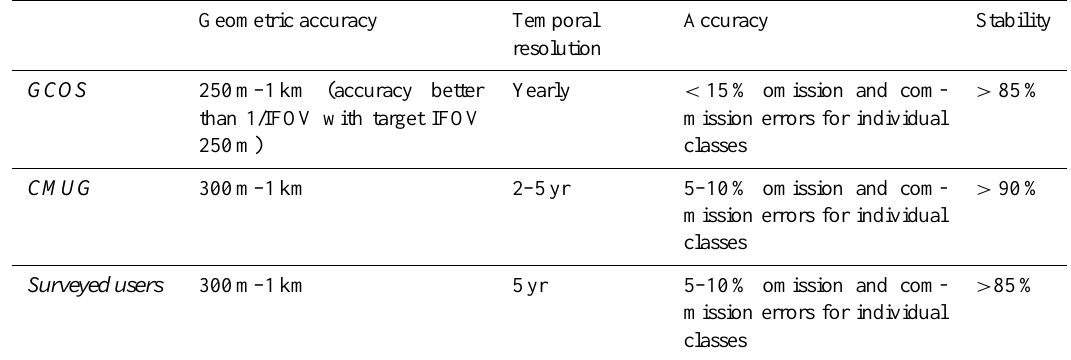
Table 2. Comparison of GCOS, CMUG and surveyed users expectations for different characteristics of global land cover products.